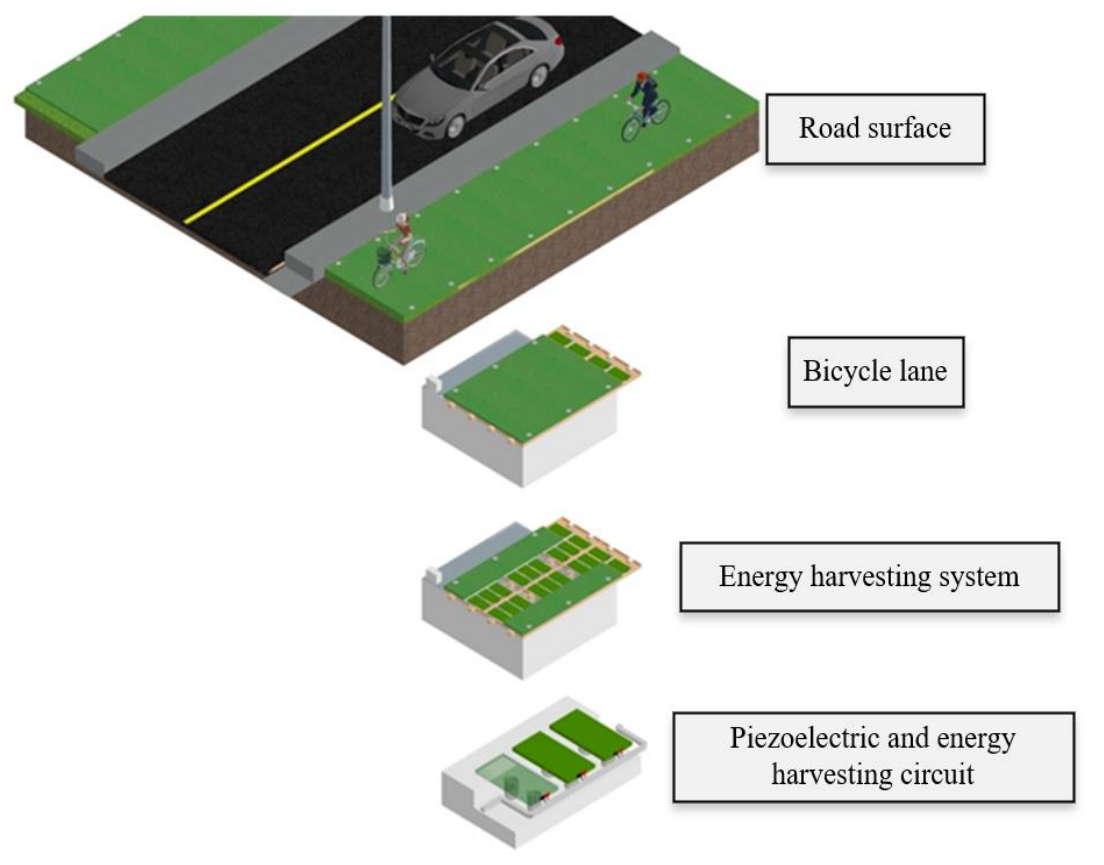
Figure 1. Conceptual framework of proposed system.